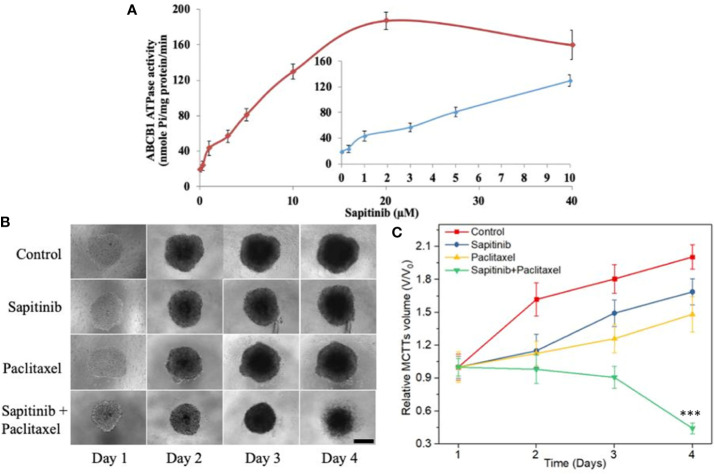
The effect of sapitinib on the ATPase activity of ABCB1 transporter and the growth of multicellular tumor spheroids. (A) Effect of sapitinib (0.625–40 μM) on the ATPase activity of ABCB1 transporter in membrane vesicles of High Five insect cells. (B) The effect of the incubation of sapitinib, paclitaxel and the paclitaxel + sapitinib on the growth of SW620/Ad300 MCTSs (sapitinib: 5 μM; paclitaxel: 1 μM). Scale bar = 300 μm. (C) The corresponding relative volume change (V/V0) from control ***P < 0.001 versus Paclitaxel.